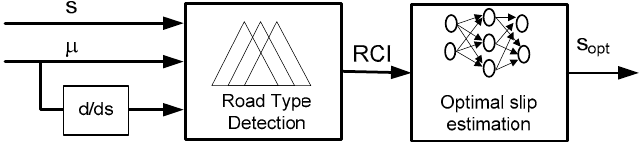
Figure 8. Control of road type and estimation of optimum slip.